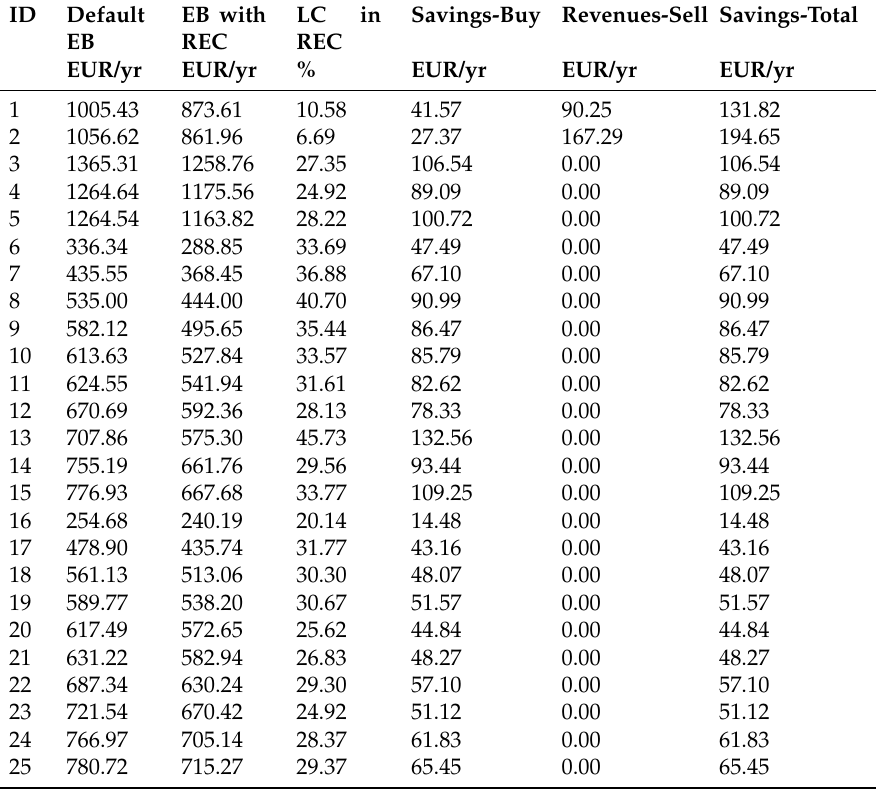
Table 8. REC of residential customers and a stand-alone PV plant: Results for customers 1–25.